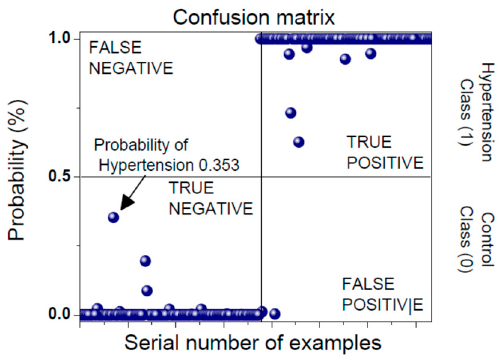
Figure 7. Confusion matrix: an arrow shows the decision considering the new feature set.